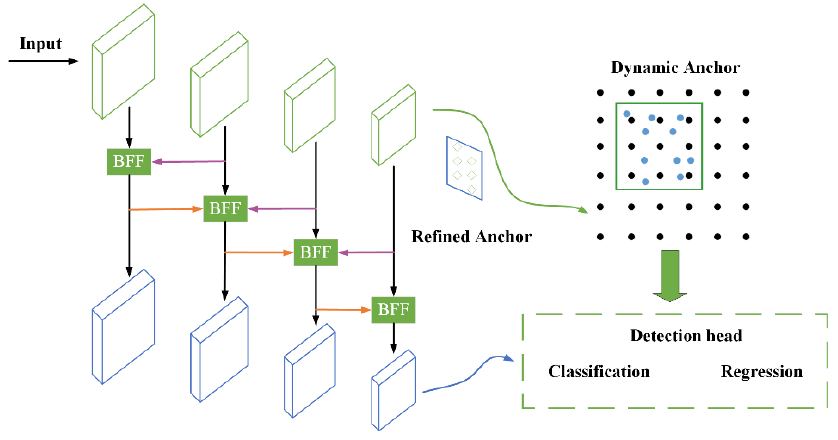
Figure 5. Structure of the DAFS model.